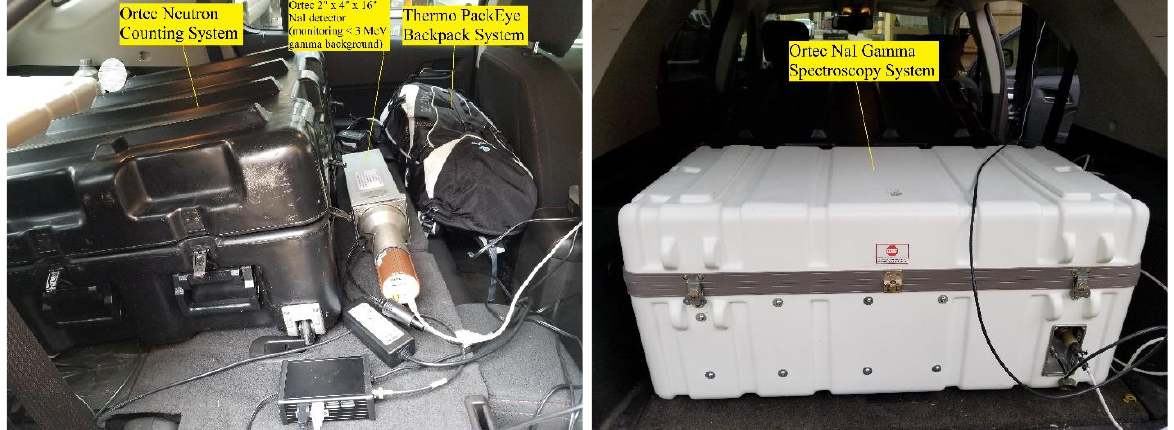
Figure 4. Photos displaying the detector systems’ placements when mounted in an SUV-type vehicle for these measurements looking into the vehicle from the rear passenger side door (left) and the trunk